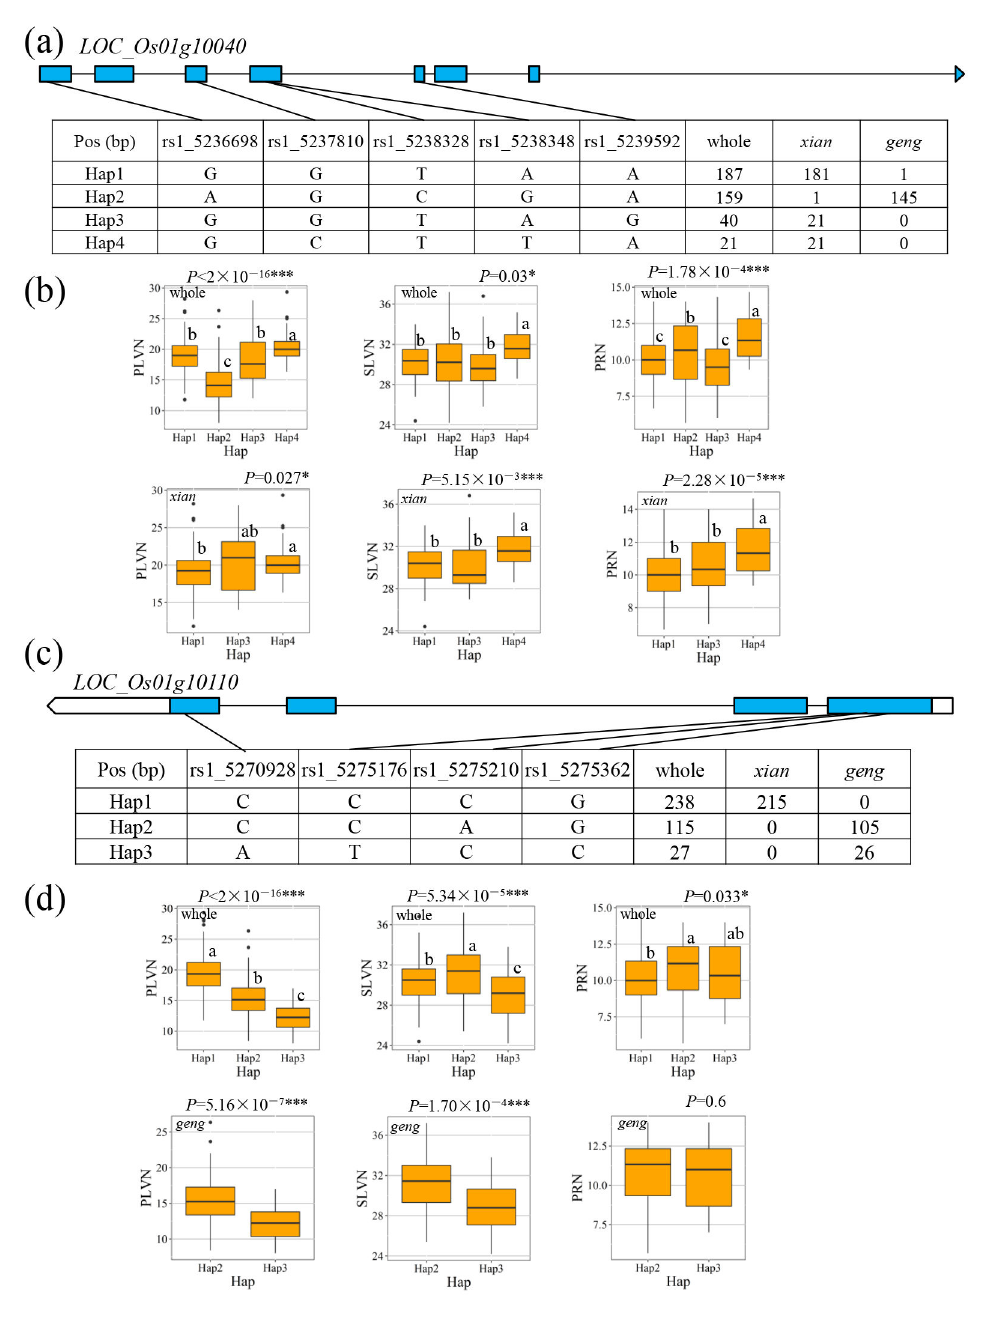
Figure 6. Haplotype analysis of the LOC_Os01g10040 and LOC_Os01g10110 candidate genes for PLVN, SLVN, and PRN at qPLVN1.1 , qSLVN1.1, and qPRN1.2 ( a ) Exon-intron structure of LOC_Os01g10040 and DNA polymorphism in that gene. ( b ) Boxplots for PLVN, SLVN, and PRN based on the haplotypes (Hap) for LOC_Os01g10040 in the whole and xian populations. ( c ) Exon- intron structure of LOC_Os01g10110 and DNA polymorphism in that gene. ( d ) Boxplots for PLVN, SLVN, and PRN based on the haplotypes (Hap) for LOC_Os01g10110 in the whole and xian popula- tions. * and *** represent significance of ANOVA at p < 0.05 and p < 0.001, respectively. Letters on the histogram (a, b, and c) are ranked by Duncan’s test at p < 0.05. PLVN: number of large vascular bundles in panicle neck; SLVN: number of large vascular bundles in second internode; PRN: number of primary rachis